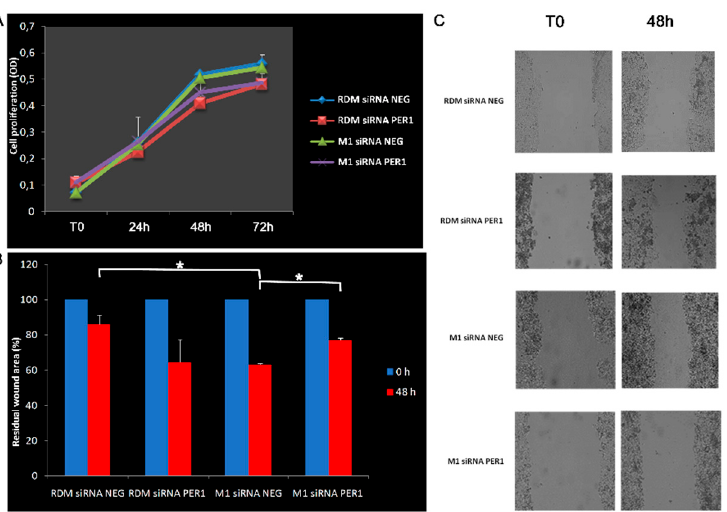
Figure 3. Evaluation of proliferative and migratory capacity: ( A ) cell proliferation curves; ( B ) wound area relative to closure (%) assessed at 48 h. Artificial wounds were made in confluent monolayers of control and macroH2A1 KO with or without PER1-silencing cells. Cell migration towards the wound, photographed from 0 h to 48 h. ( C ) Representative microphotographs of the residual wound area. Original magnification 10X. Cell migration was determined by the rate of scratched area closure over time using ImageJ™ software. See the Materials and Methods section for more details. RDM siRNA NEG = siRNA scramble-treated HepG2 cells; RDM siRNA PER1 = siRNA PER1-treated HepG2 cells; M1 siRNAneg = siRNA scramble-treated macroH2A1 knocked down HepG2 cells; M1 siRNA PER1 = siRNA PER1-treated macroH2A1 knocked down HepG2 cells; bars, standard error of mean (SEM); * p < 0.05; three biological replicates were each assayed in triplicate and results were expressed as mean ± standard error of mean